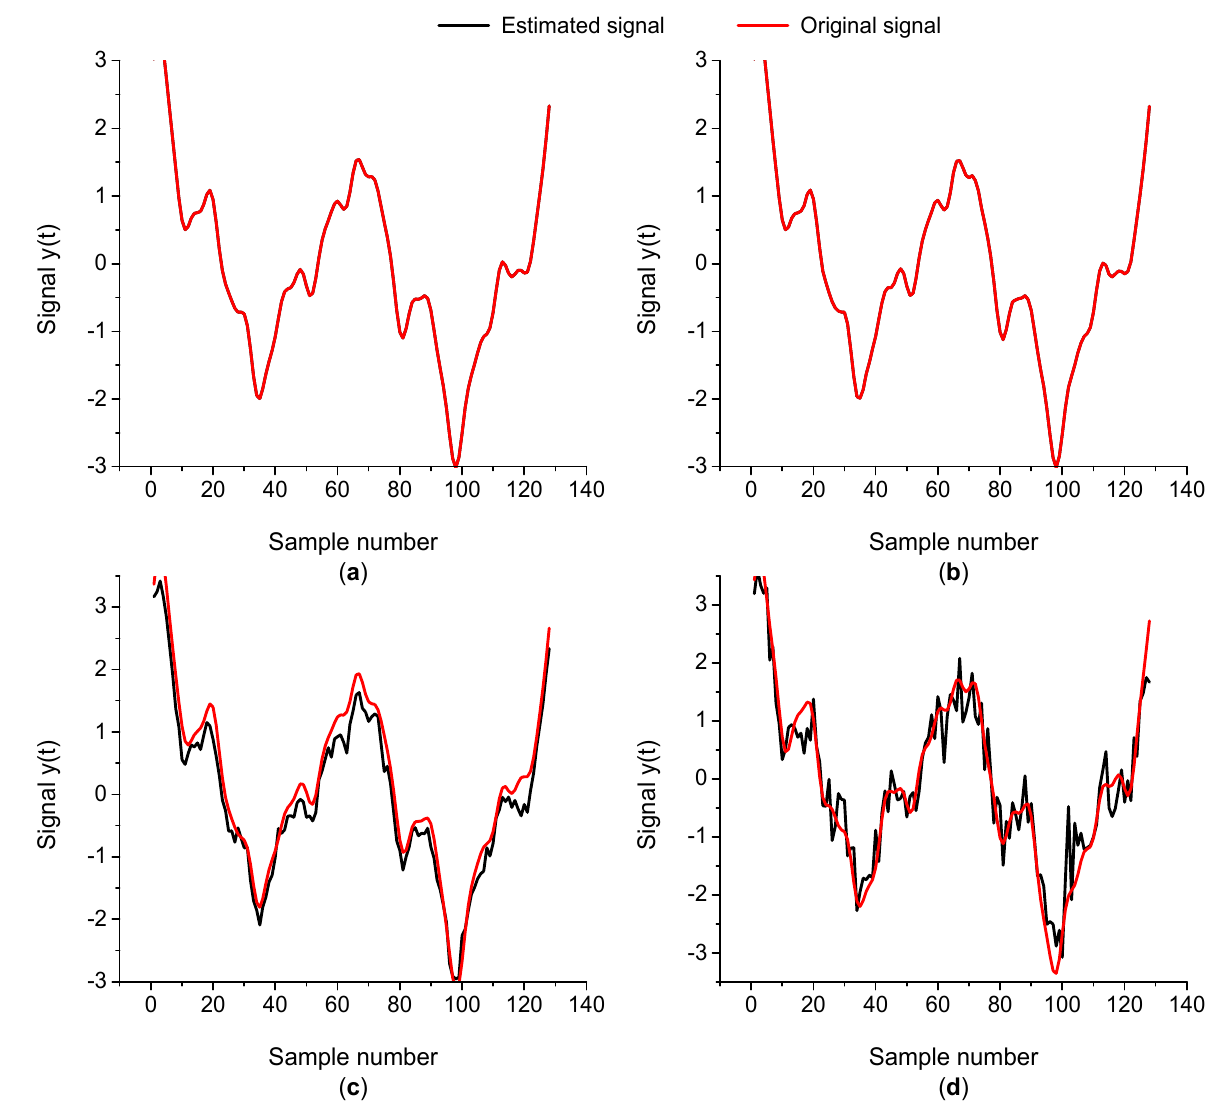
Figure 14. Actual and Estimated signal comparison ( a ) non-noisy, ( b ) 40 dB noise level, ( c ) 20 dB noise level and ( d ) 10 dB noise level.